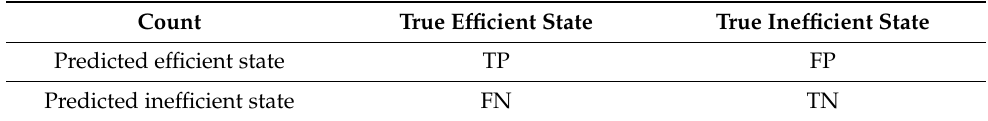
Table 3. The Confusion Matrix of ML model. Count True Efficient State True Inefficient State Predicted efficient state TP FP Predicted inefficient state